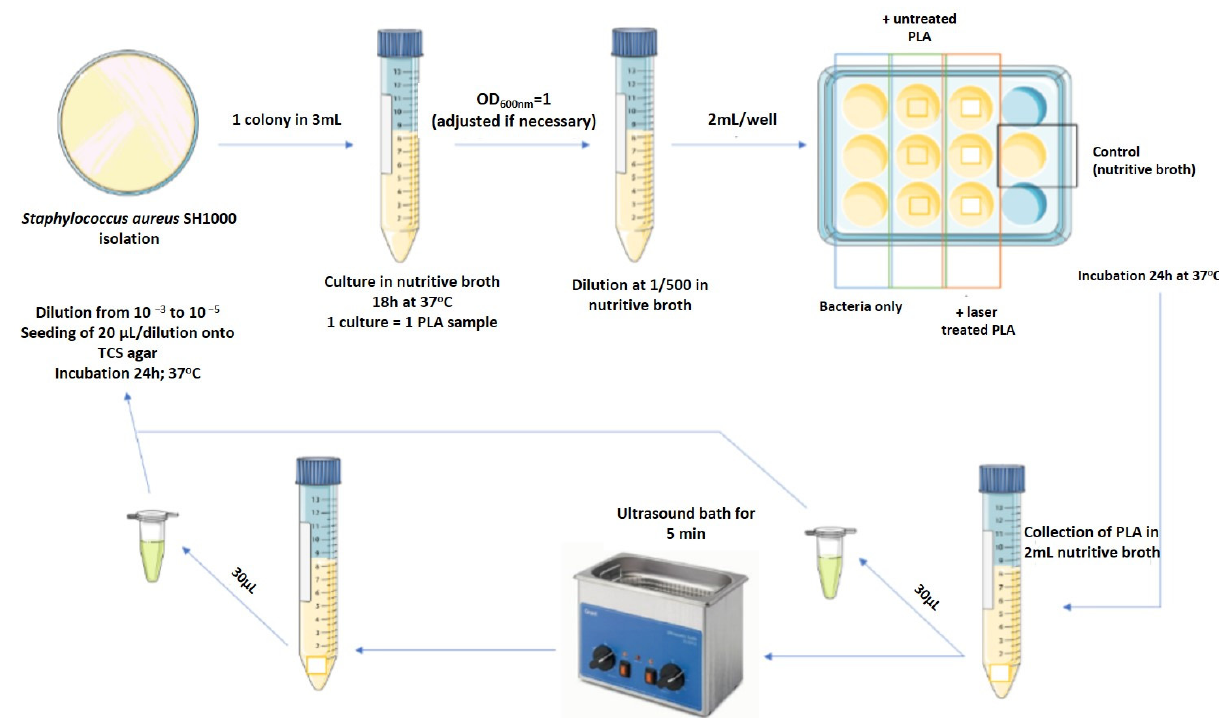
Figure 5. Scheme of the used microbiology protocol.